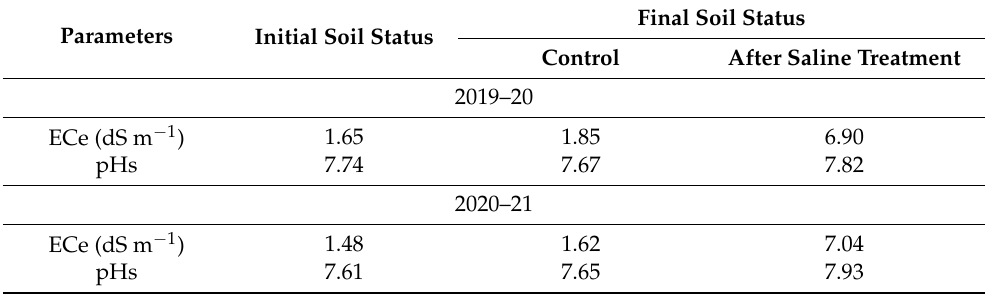
Table 2. Soil status: Initial and final soil